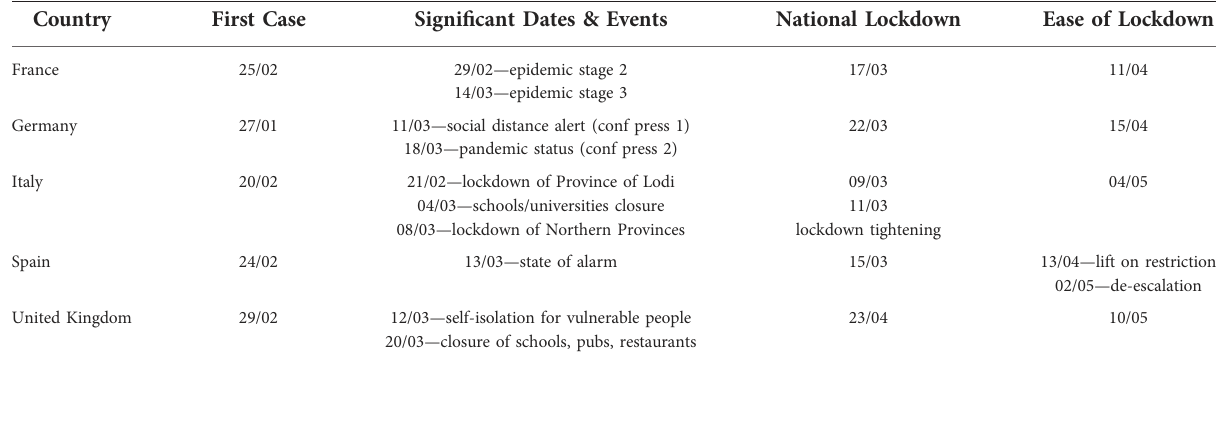
TABLE 2 Summary of the main relevant lockdown milestones of the 5